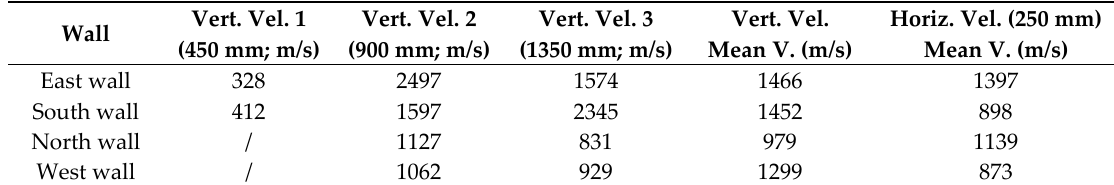
Figure 4. Krishna Temple, Bhaktapur. Table 2. Indirect STs, Krishna Temple.